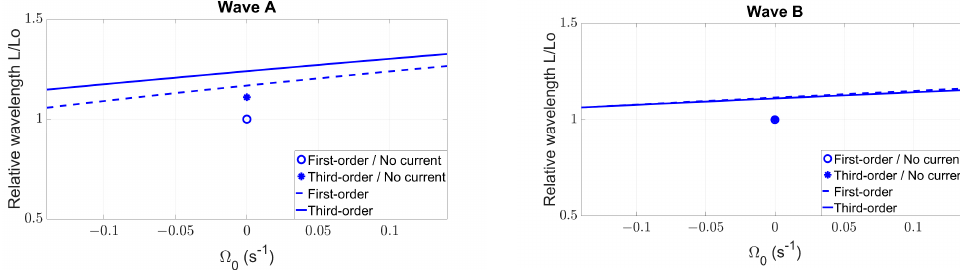
Figure 9. Relative wavelength as a function of vorticity. U m = 0.35 m/s.